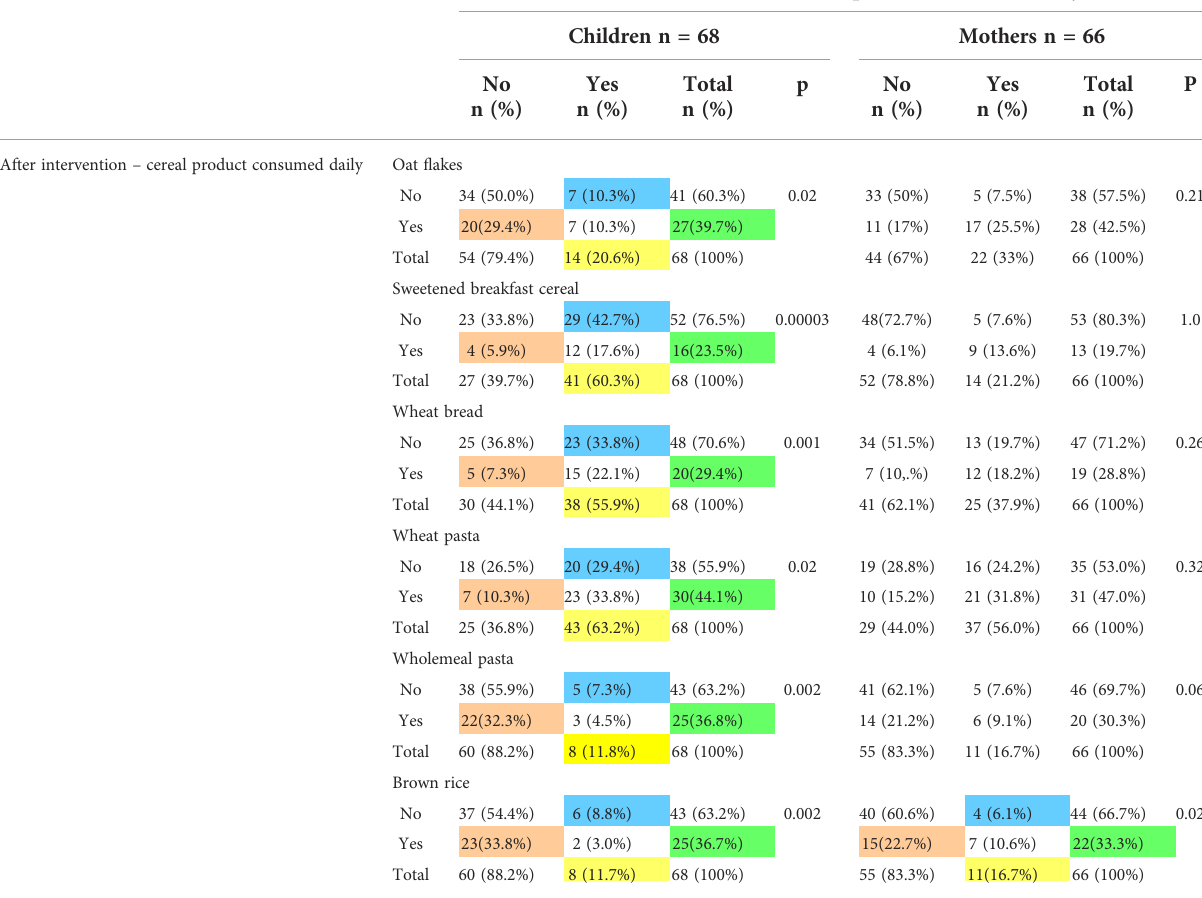
TABLE 6 Effect of one-year dietary intervention on cereal products consumption in studied children and their mothers. Assessed habit Before intervention – cereal product consumed